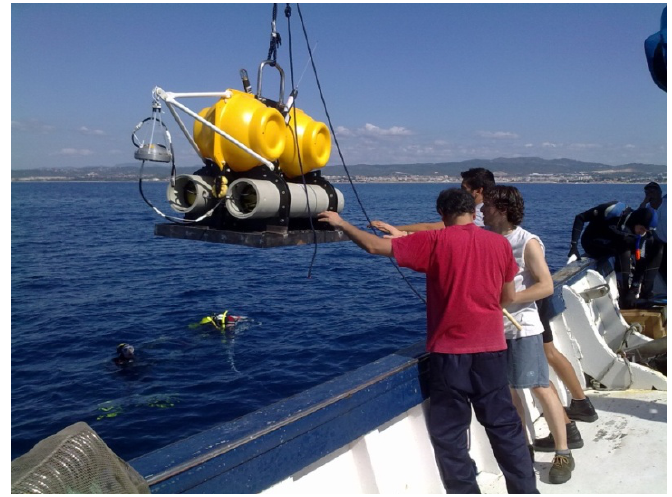
Figure 2. OBS ready for deployment.